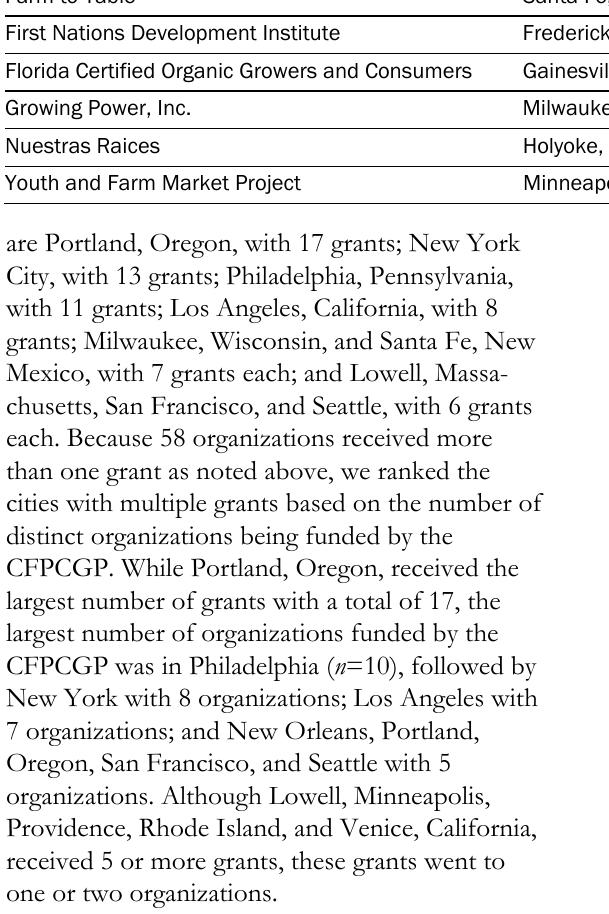
Table 4. Common Activities and Target Groups, 1996–2012 ( N